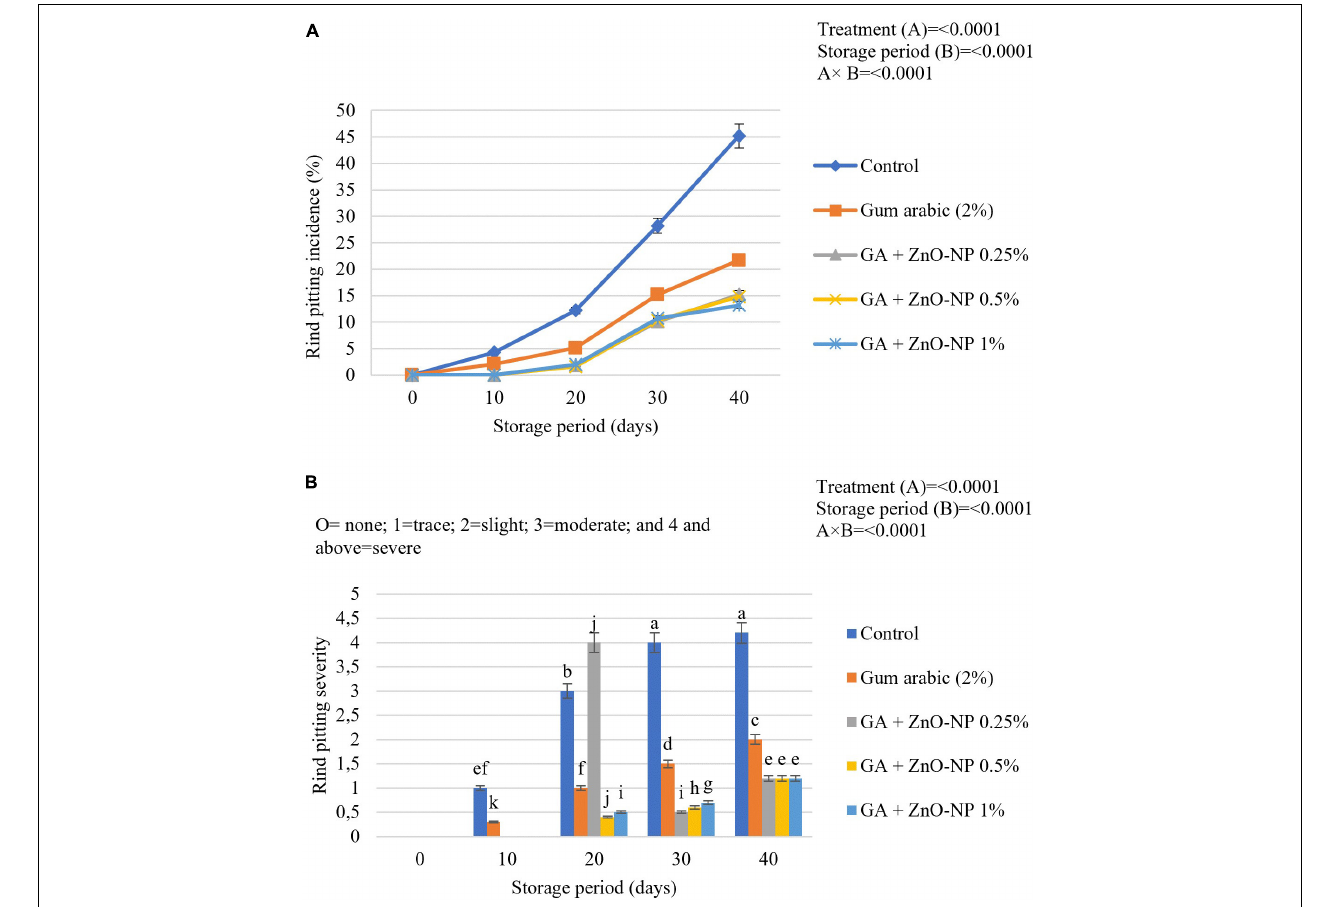
FIGURE 10 | (A) Rind pitting incidence and (B) rind pitting severity of ‘Kinnow’ mandarin fruit during storage for 40 days at 5 ± 1 ◦ C and additional 5 days at 20 ± 5 ◦ C. Error bars denote the standard error (SE) of the mean. Means ± standard errors presented. To determine the interaction effects, factorial ANOVA was performed for the main factors, treatment, and storage time. GA + ZnO-NP, gum arabic + zinc oxide nanoparticles. Bars followed by different letters are significantly different at p < 0.05 according to Duncan’s multiple range